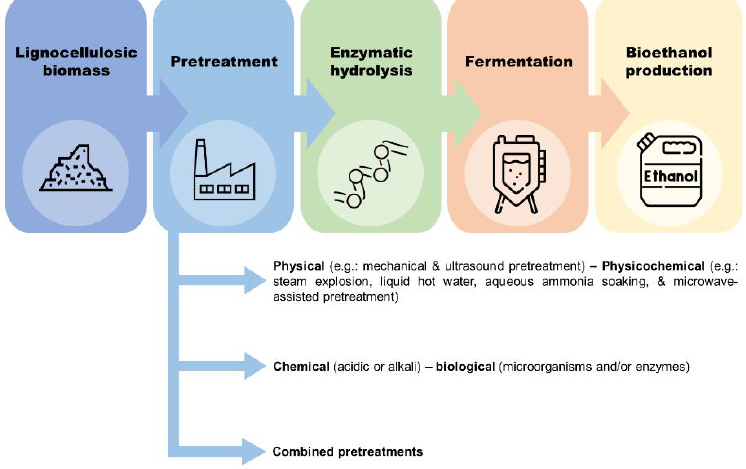
Figure 5. General overview of bioethanol production from lignocellulosic biomass.